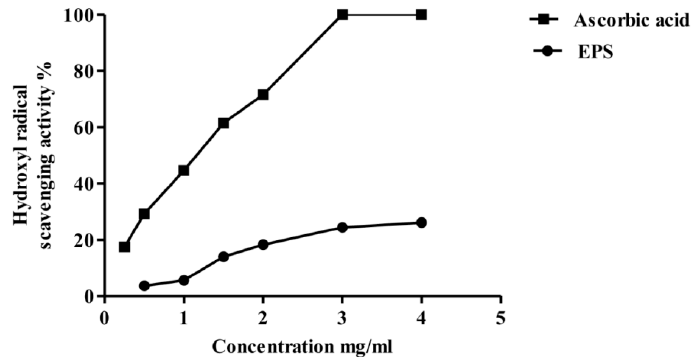
Figure 8. Hydroxyl radical scavenging activity of different concentrations of MOE6-EPS (0.5, 1, 1.5, 2, 3, 4 mg/mL) from Streptomyces sp. MOE6 compared to that of ascorbic acid (0.25, 0.5, 1, 1.5, 2, 3, 4 mg/mL) as a positive control. Values are means ± SD ( n = 3). 100% w/v of OH − was 340 μ g /mL. The absence of error bars indicates that the errors were smaller than the symbols.